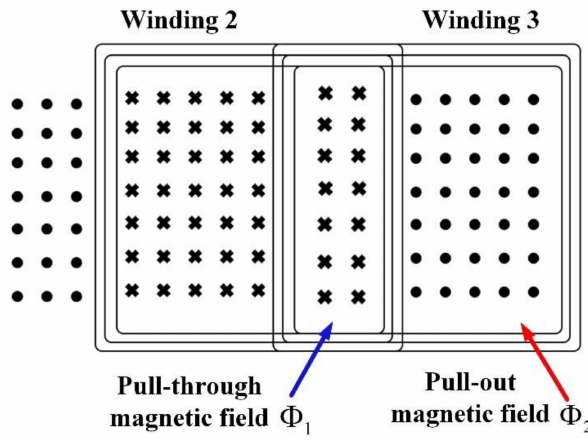
Figure 17. Schematic diagram of winding